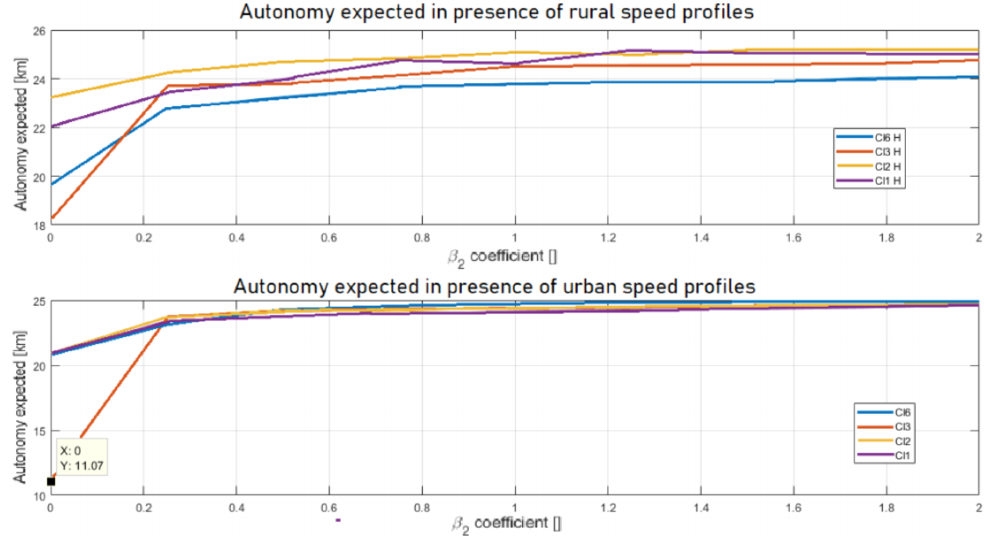
Figure 24. Autonomy comparison.